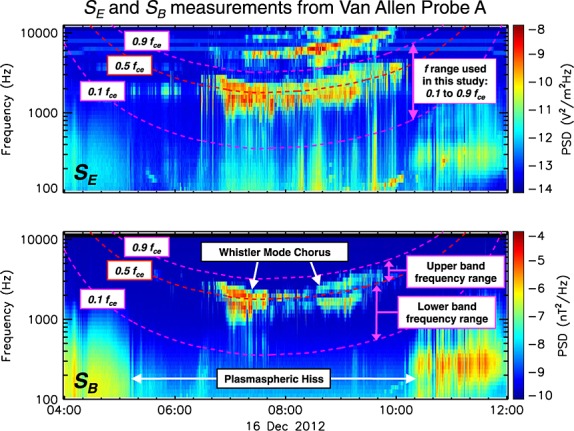
A survey plot of the (top) electric, SE, and (bottom) magnetic, SB, wave spectral intensity observed by Van Allen Probe A during an 8h period on 16 December 2012. The dashed pink lines indicate 0.1 and 0.9 fce, and the dashed red line indicates 0.5 fce as calculated from the onboard magnetometer measurements. Whistler mode chorus waves and plasmaspheric hiss are highlighted in the spectrogram.